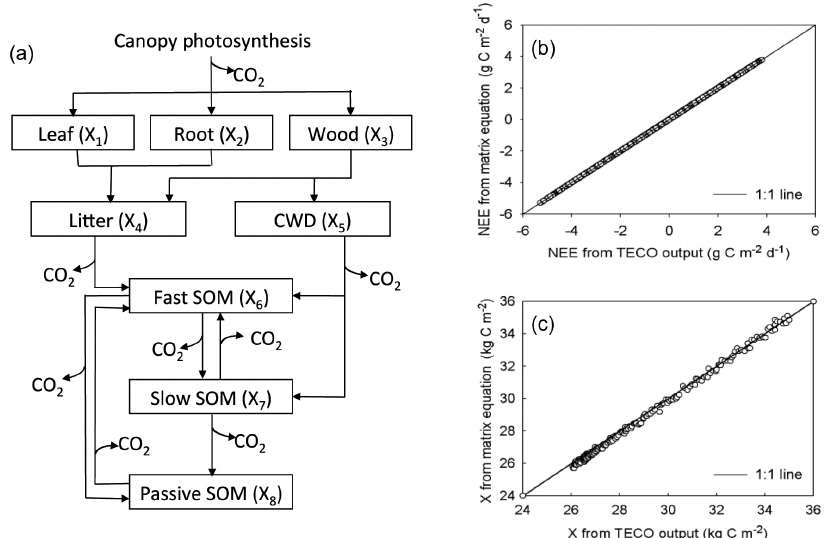
Figure 1. The Terrestrial ECOsystem (TECO) model and its outputs. Panel (a) is a schematic representation of C transfers among multiple pools in plant, litter, and soil in the TECO model. TECO has feedback loops of C among soil pools. CWD is coarse wood debris, SOM is soil organic matter. Panel (b) compares the original TECO model outputs with those from matrix equations for net ecosystem production (NEP is the sum of elements in X (cid:48) (t) from Eq. 1). The perfect match between the TECO outputs and NEP from Eq. (1) is due to the fact that they are mathematically equivalent. Panel (c) compares the original TECO model outputs with those from matrix equations for ecosystem C storage (equal to the sum of elements in X (t) from Eq. 2). The C storage values calculated with Eq. (2) are close to a 1:1 line with r 2 = 0 . 998 with the modeled values (c) . The minor mismatch in estimated C storage between the matrix equation calculation and TECO outputs is due to numerical errors via inverse matrix operation with some small